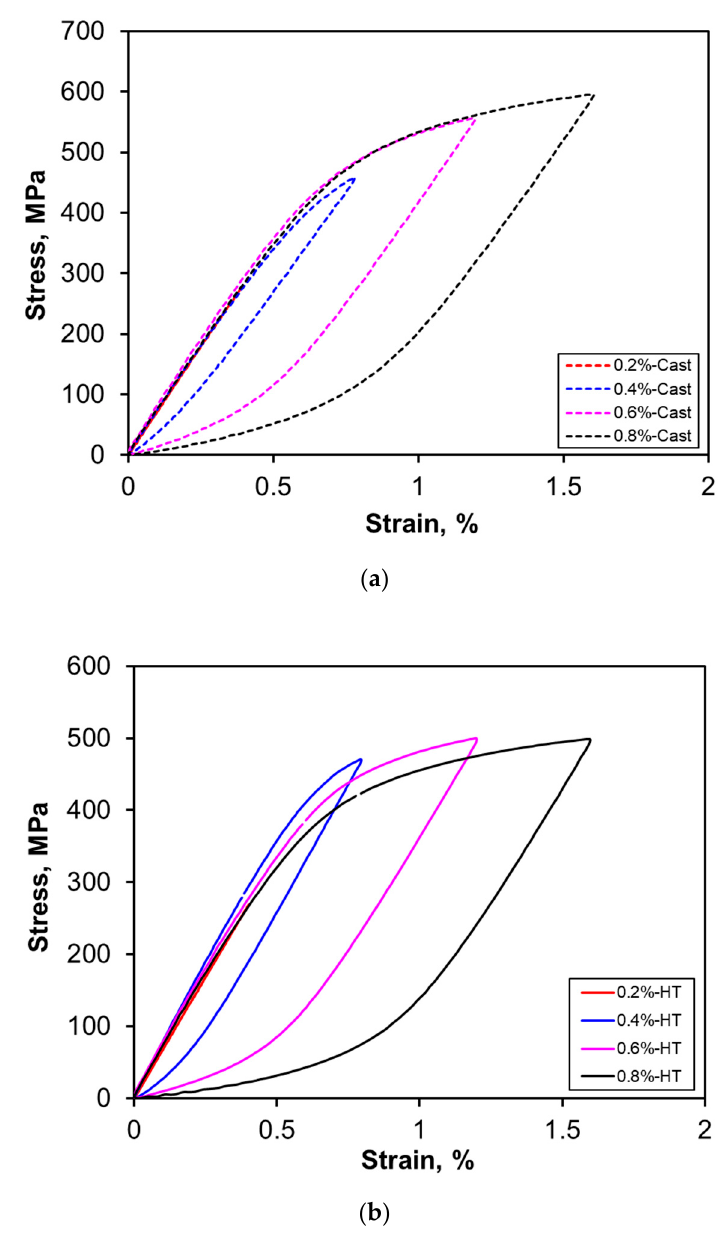
Figure 8. Typical hysteresis loops at various total strain amplitudes of AlMgSiMnFe alloy, showing ( a ) Masing behavior in the as-cast alloy and ( b ) non-Masing behavior in the HT alloy.